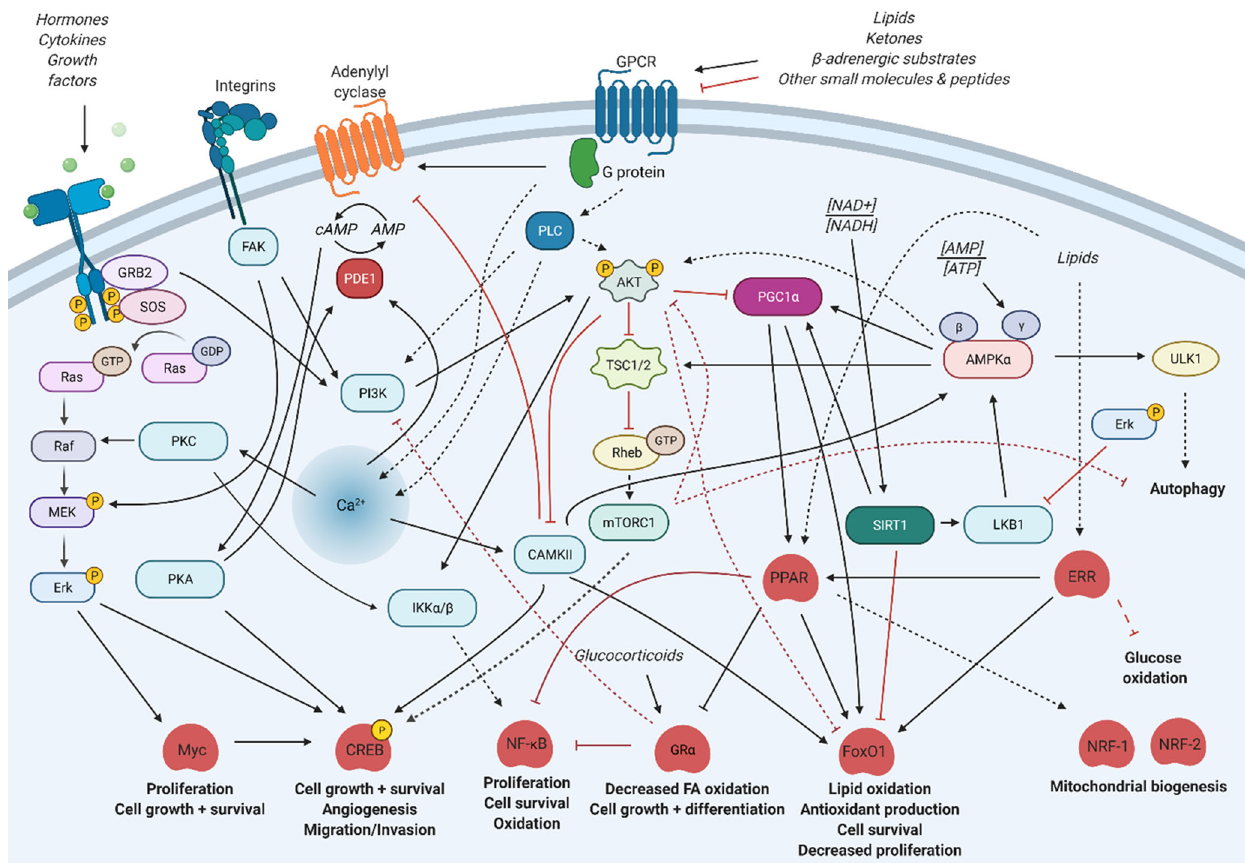
Fig. 2 Simpli fi ed visualization of common convergences between ubiquitous signaling pathways in fl uencing tissue maturation. Black arrows represent activation while red hashes represent inhibition; solid lines represent putatively direct interactions while dashed lines represent indirect effects (intermediates not shown or unknown). Image created using